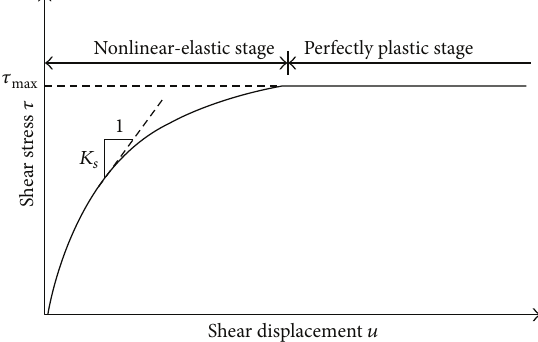
Figure 9: Nonlinear-elastic perfectly plastic model of